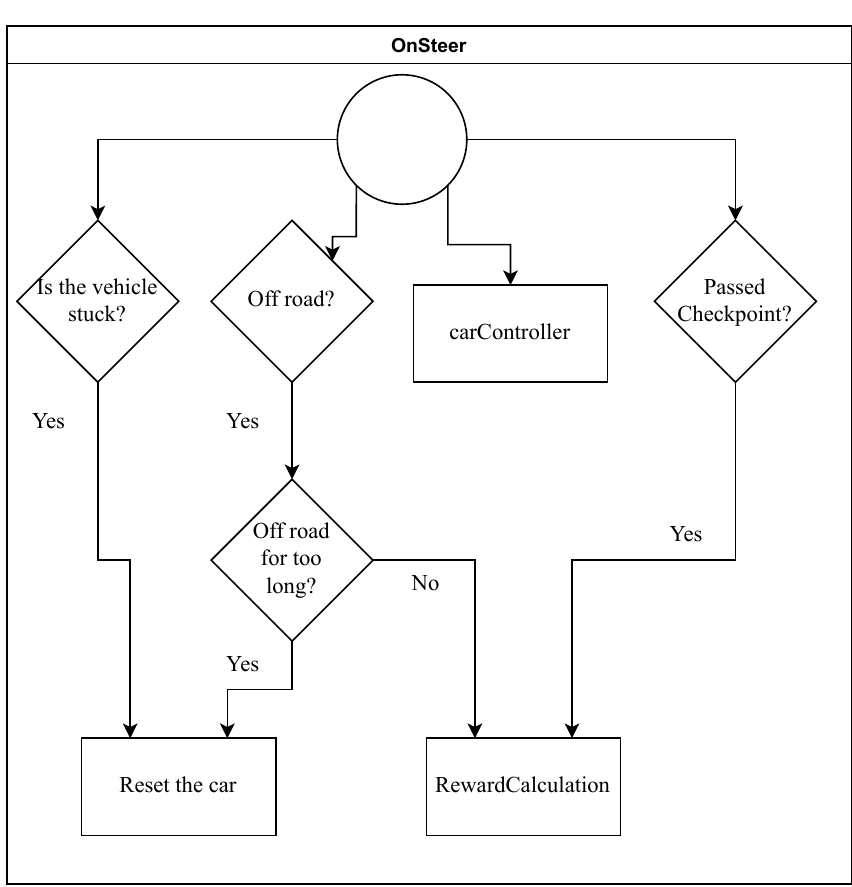
Figure 1. Interaction when given a steering command. The container is the function used, namely onSteer. The rectangles represent actions, e.g., resetting the vehicle or steering the vehicle. The rhombuses represent if statements, e.g., if the vehicle passed a checkpoint, give it a